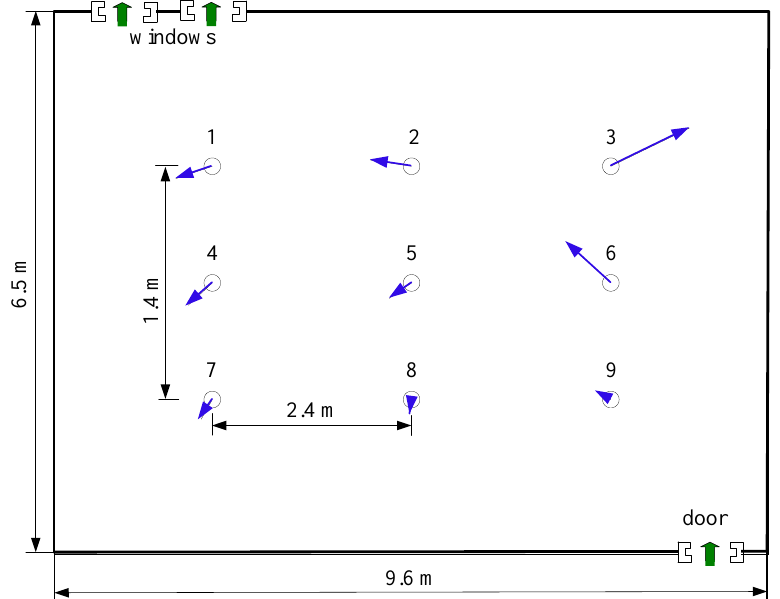
Figure 10. The average natural wind speed and direction of each anemometer over 150 seconds in Arena II. The arrows indicate the directions of the airflow and their lengths indicate the